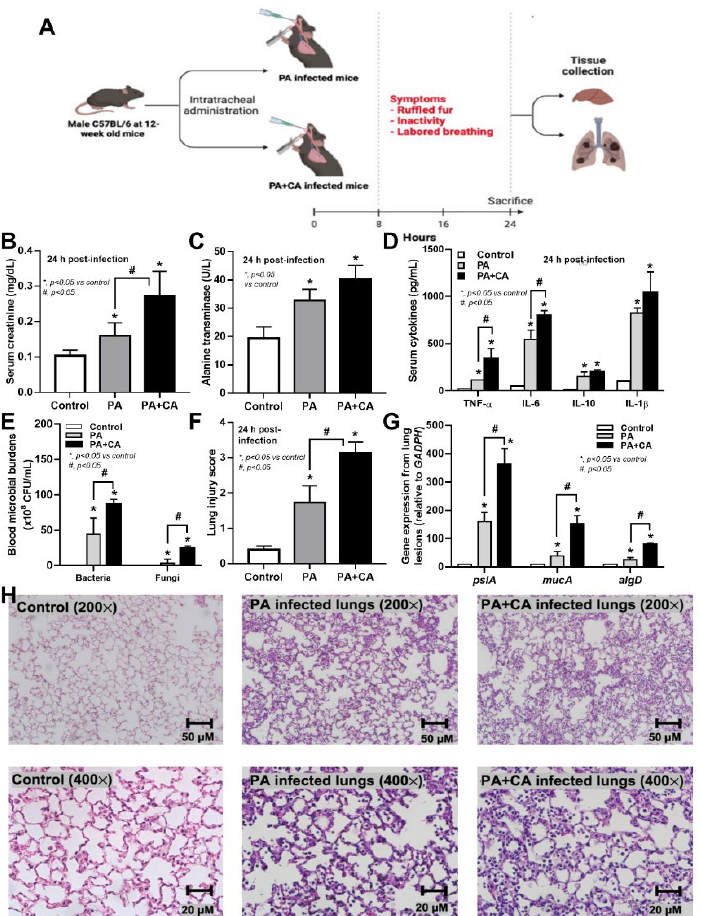
Figure 4. The experimental schema ( A ) was created using BioRender (http://app.biorender.com/) on 25 June 2022. The characteristics of sepsis in mice with pneumonia after administration of Pseudomonas alone (PA), Pseudomonas with Candida (PA+CA), or control, as indicated by serum creatinine ( B ), liver enzyme ( C ), serum cytokines (TNF- α , IL-6, IL-10, and IL-1 β ) ( D ), bacteremia burdens ( E ), lung injury score ( F ), and the expression of biofilm-associated genes (pslA, mucA, and algD) ( G ), and the representative pictures of lung lesions ( H ) ( n = 6–7 per